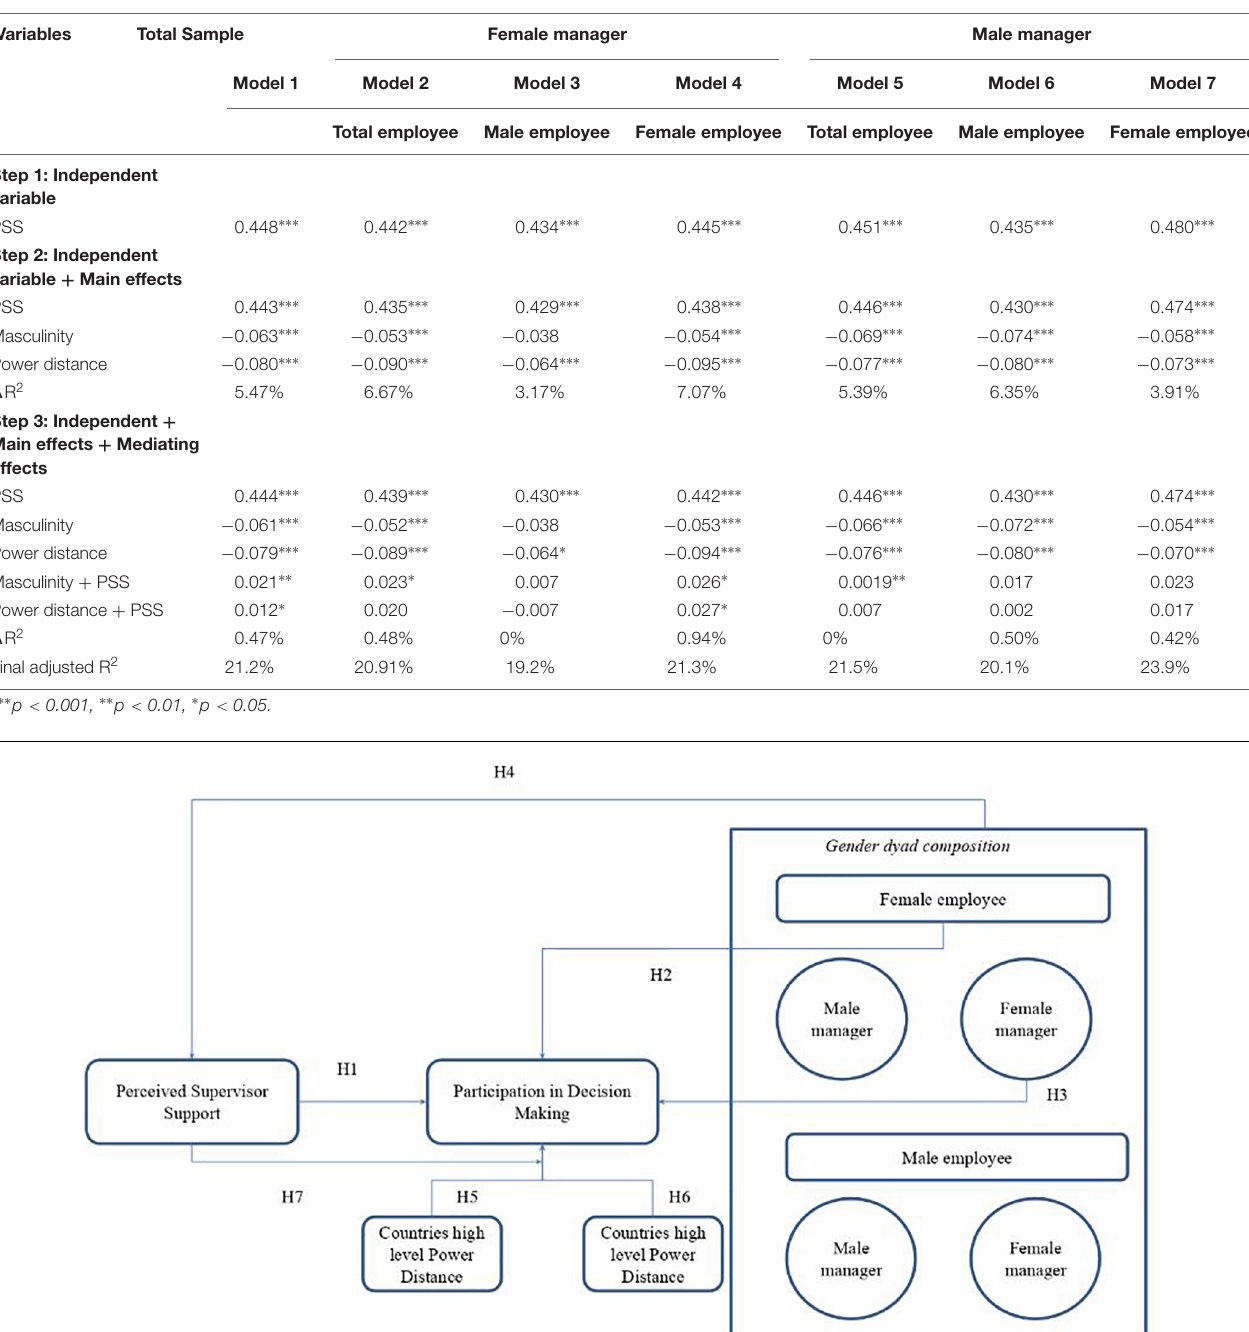
the relationship studied, and after detecting differences in the linear association between PSS and PDM variables according to the gender dyad composition, the regression model was applied over different subsamples. Concretely, Models 2 and 5 are associated with those samples with female and male